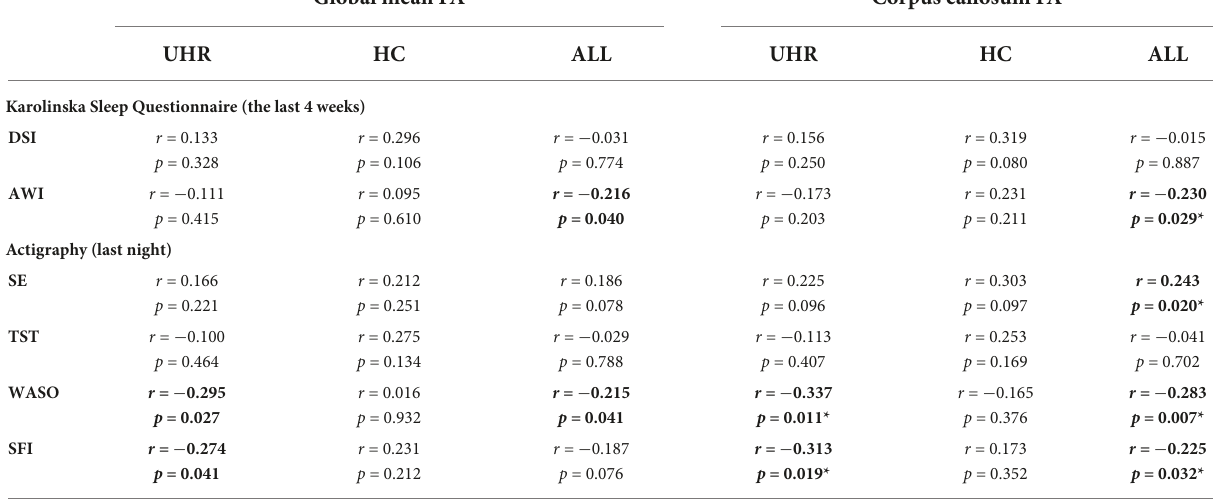
Tabledisplaysresultsfromthepartialcorrelation-analysesbetweenmeanglobalandcallosalfractionalanisotropy(FA)andsleepparameters,covariedforage,sex,andrelativeandabsolute motioninscanner.Pearson’scorrelationtestsweretwo-tailed.Bootstrapping( × 1,000)wasperformedtoprovideconfidenceintervals. Significance level under p < 0.05 are marked in bold. *Indicates significant correlation p < 0.05 after FDR correction for multiple comparisons according to the Benjamin-